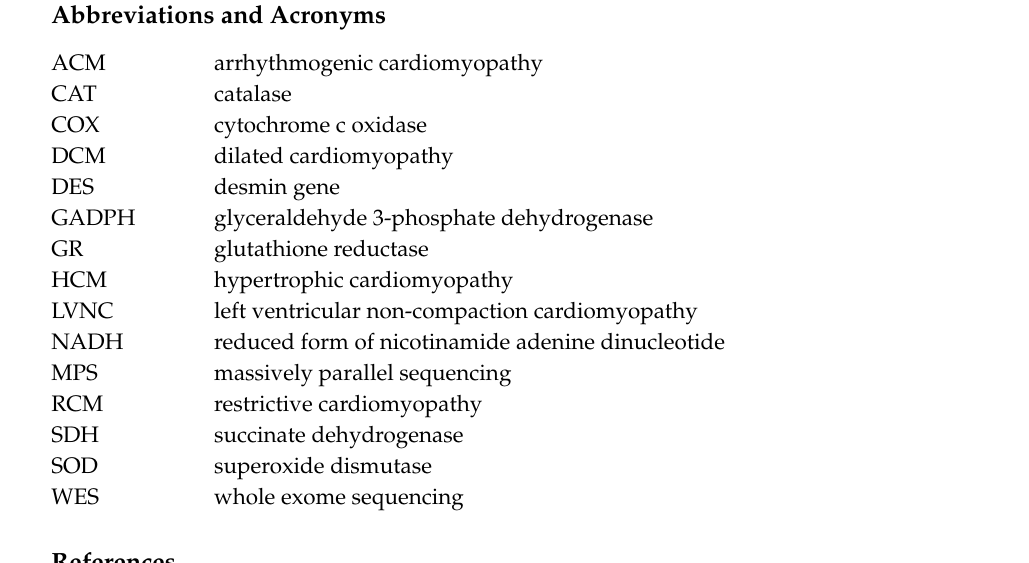
Table S1 Primers for PCR Amplification of DES for segregation analysis in families, Table S2 Main clinical characteristics of probands, Table S3 Additional clinical, electrocardiographic, laboratory and echocardiographic data of probands, Table S4 Rare variants of non-desmin genes in probands, frequency in Exac database less than